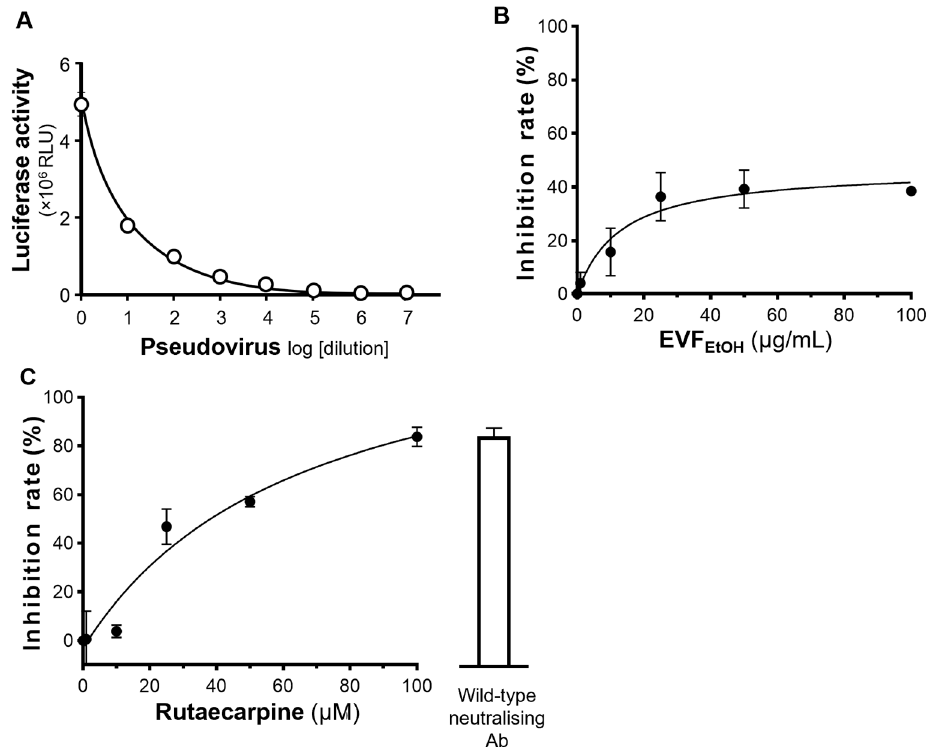
Figure 4. EVF EtOH and rutaecarpine block entry of wild-type pseudovirus into HEK293T cells overexpressing ACE2. ( A ) The ELISA assay successfully demonstrated the entry of pseudovirus into these cells, exhibiting a dose-dependent response to dilution of the virus. ( B ) EVF EtOH and ( C ) rutaecarpine blocked entry of the pseudovirus into the cells in dose-dependent manner. SARS-CoV-2 neutralising antibody was used at 1 µg/mL as a positive control. The values represent the mean ± SD percentage of inhibition to control (with no drug treatment) and n = 3.